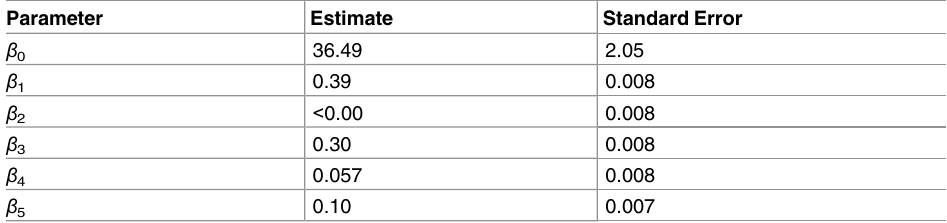
Table 4. Results of Poisson time series regression INARCH model for daily time series of AI-related Twitter activity (Log-likelihood: -8907.42, AIC: 17826.85,log score: 6.26, ranked probability